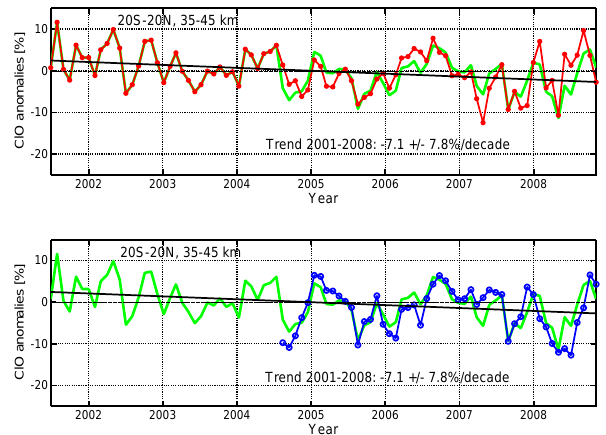
Fig. 9. ClO anomalies for SMR (red) and MLS (blue) for 20 ◦ S– 20 ◦ N and 35–45km. Also shown under-laid is the all instrument average (green). The solid black line shows the linear trend fitted to the all instrument average. Trend value given in %decade − 1 and uncertainties are at 2 standard deviations.